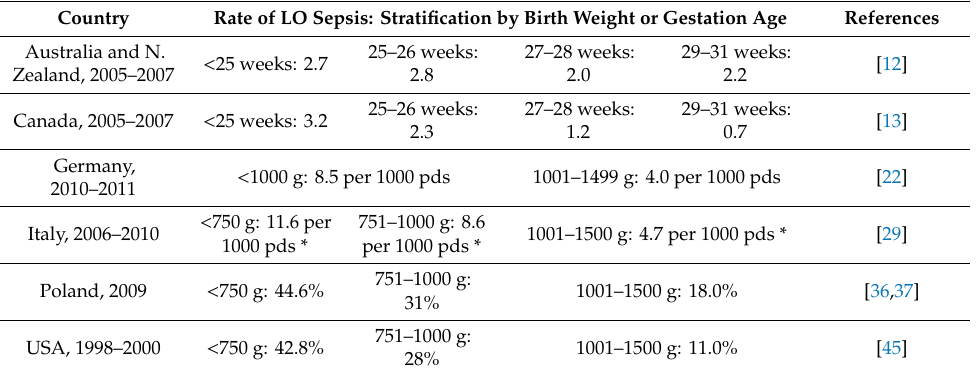
Table 3. Comparison of the late-onset (LO) sepsis incidence rates stratified by birth weight or gestation age (in alphabetical order). Country Rate of LO Sepsis: Stratification by Birth Weight or Gestation